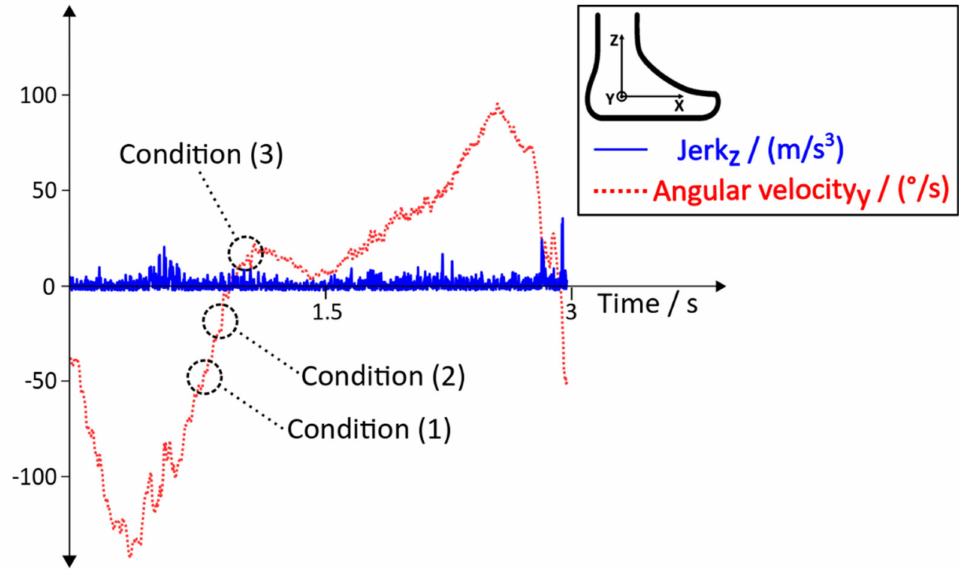
Figure 7. Angular velocity and jerk during the robot-assisted gait training of a stroke